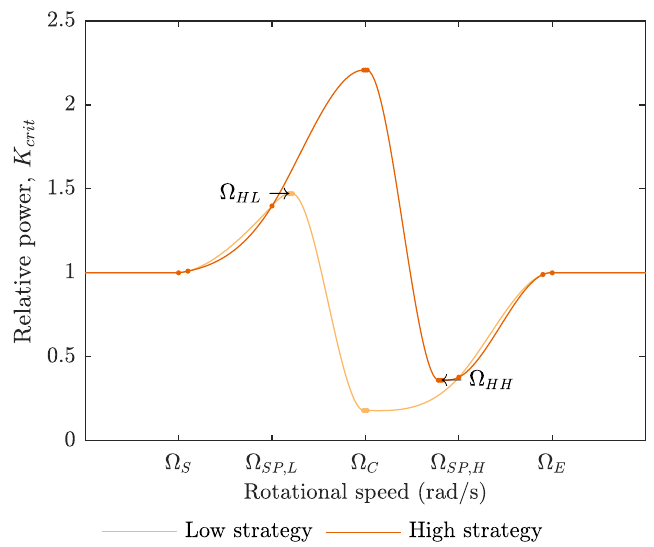
Figure 2. The relative power K crit of the critical speed controller, as a function of rotational speed. The key points from Table 1 are marked.